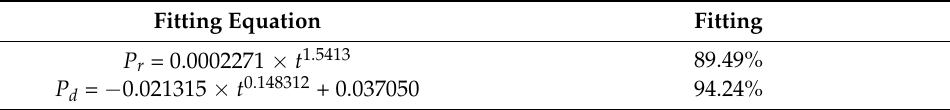
Table 2. Fitting results of recovery rate and death rate.